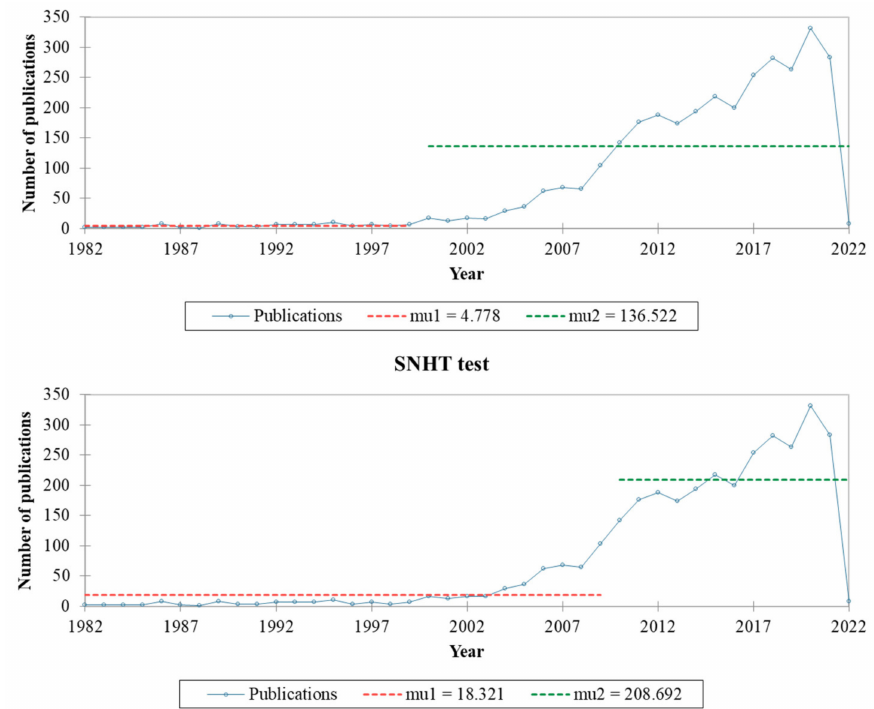
Figure A3. Significant change in number of publications with upward shift between 1982 and 2021 (mu1 and mu2 are the mean number of publications before and after the break years, respectively) based on the Pettitt and SNHT tests.